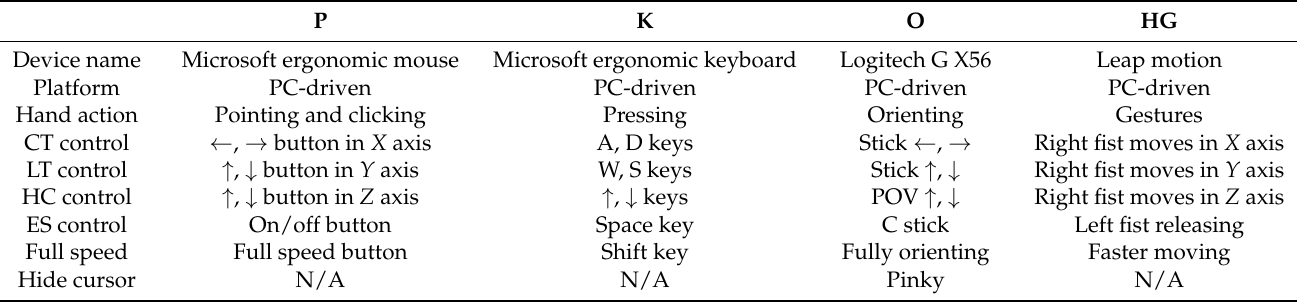
Table 1. Main control methods of input devices.